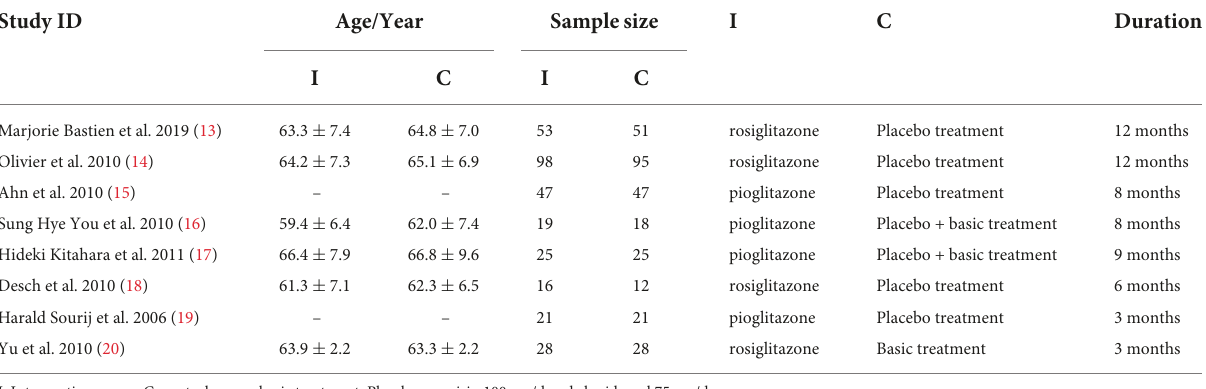
TABLE 1 The included literature feature.